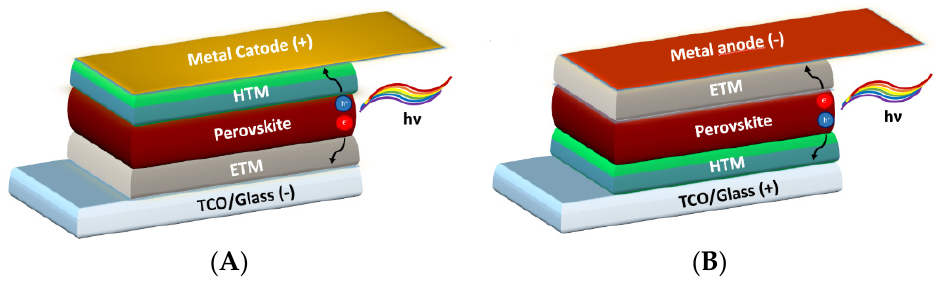
Figure 1. ( A ) Direct/n-i-p and ( B ) inverted/p-i-n perovskite solar cell.